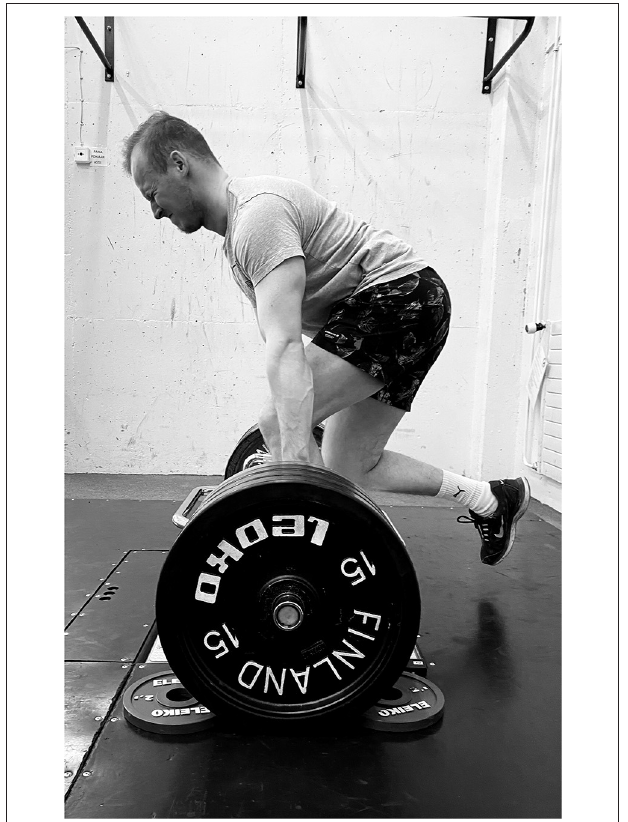
FIGURE 1 | Unilateral maximal isometric hex bar MVC